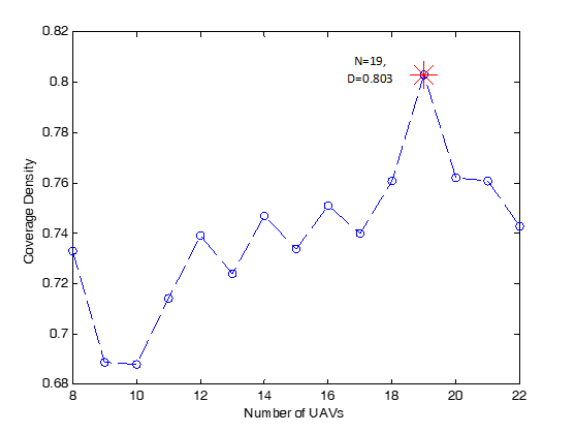
Figure 11. The coverage density of the circular coverage region with r =1125